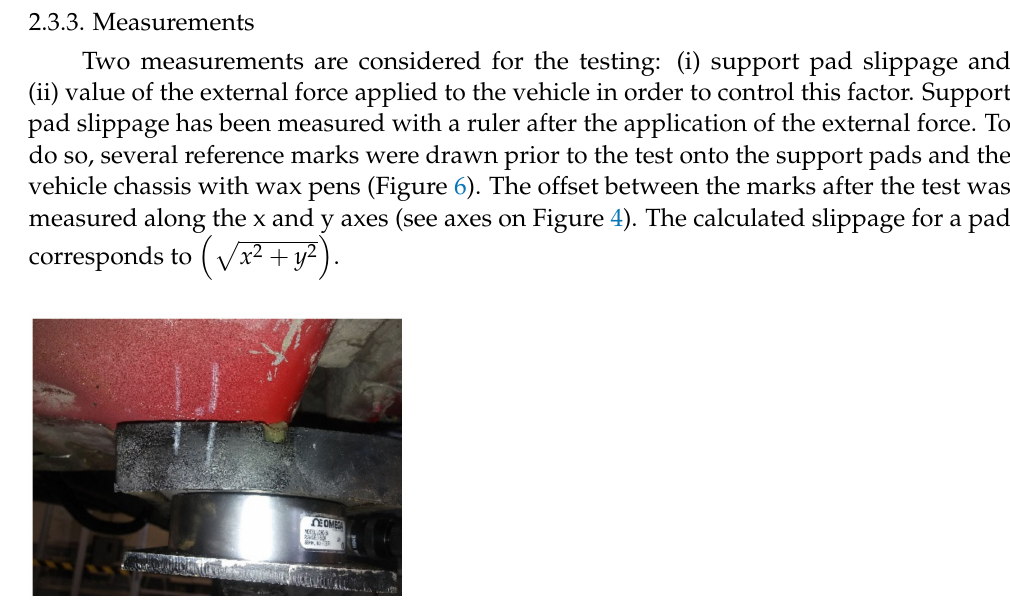
Figure 6. Reference lines on the support pad and the chassis before the test, along the x